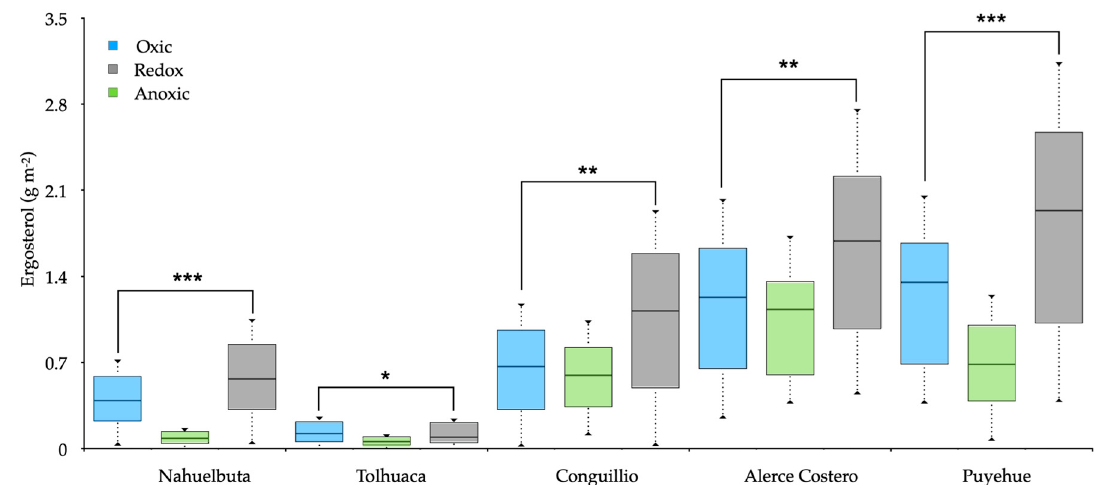
Figure 4. Boxplots for ergosterol stocks in soils inoculated with white-rot fungi obtained from various temperate forests soils incubated for 20 days under oxic, anoxic, and fluctuating redox conditions. The boxplot represents the sample median, and the first and third quartiles. Significant differences at * p < 0.5, ** p < 0.1 and *** p < 0.01.